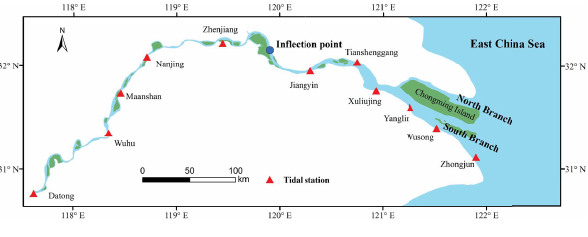
Figure 3. Sketch of the Yangtze estuary in China. Table 3. Geometric characteristics in the Yangtze estuary.